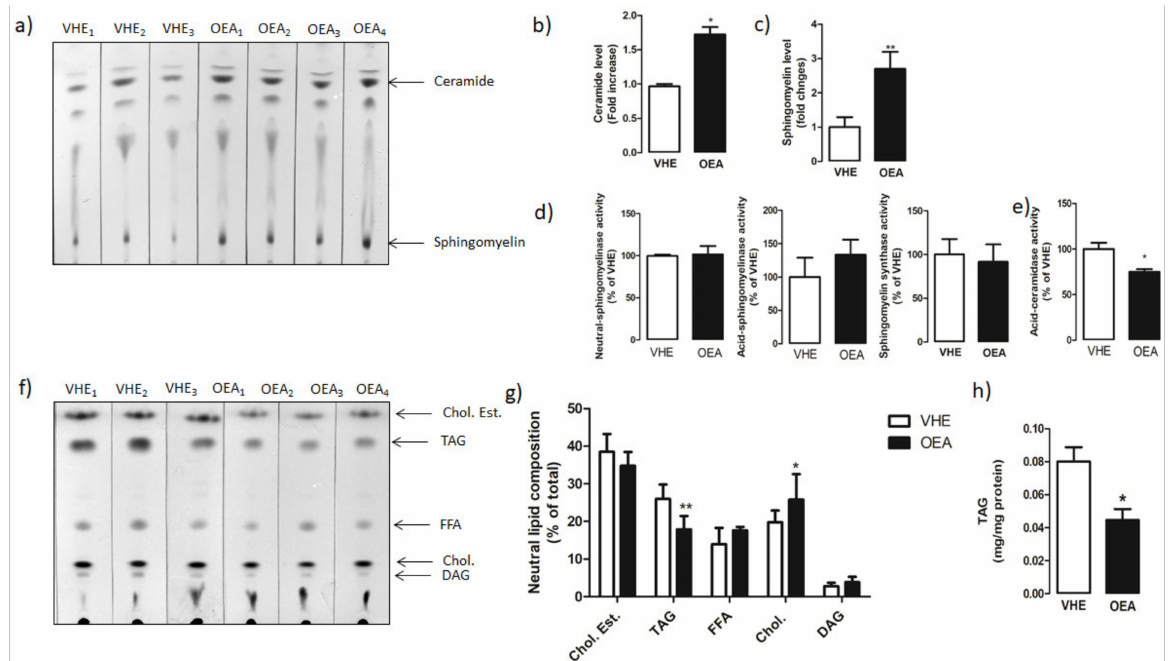
Figure 2. Hepatic sphingolipid and neutral lipid analysis. Total lipids from VEH and OEA groups were extracted and separated by TLC. ( a ) Representative TLC separation of sphingolipids. ( b , c ) Quantification of ceramide and sphingomyelin by densitometry analysis. Ceramide and sphingomyelin level is reported as fold change of OEA versus VHE. ( d ) Neutral and acid sphingomyelinase and sphingomyelin synthase activities reported as percentages of values measured in VEH. ( e ) Ceramidase activity assayed in liver homogenates. ( f ) Representative TLC separation of neutral lipids. ( g ) Neutral lipids are represented as percentage of the total. ( h ) Triacylglycerol (TAG) amount was spectrophotometrically quantified with a specific enzymatic assay. In the figure, the mean ± SEM of values obtained from three different analyses is reported. ** p < 0.005; * p < 0.05. Abbreviations: Chol. Est. = cholesterol ester; TAG = triacylglycerols: FFA = free fatty acids; DAG =